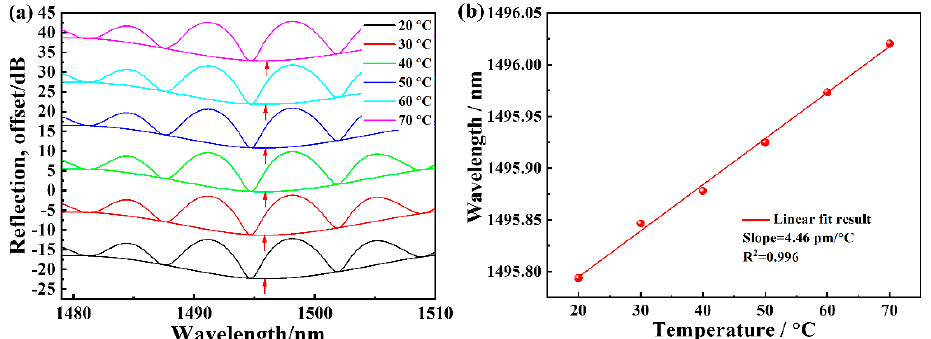
Figure 8. ( a ) Response of paralleled F–P cavities to temperature. ( b ) Linear fitting of wavelength shift versus temperature.